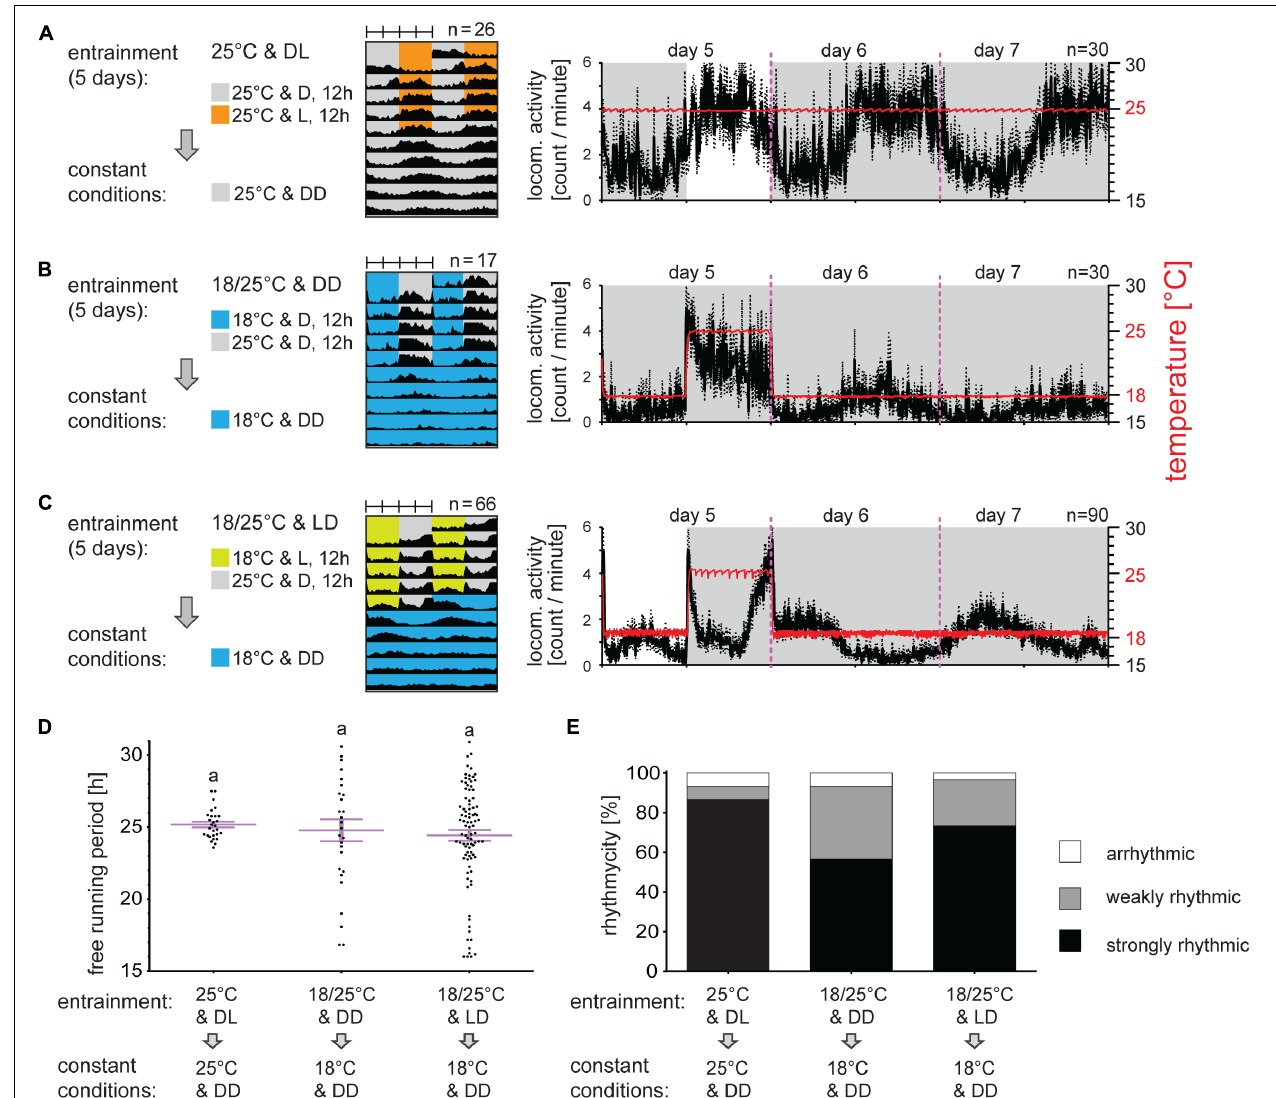
FIGURE 2 | Light is a stronger signal than the temperature for locomotor activity synchronization in P. apterus . Adult males developing under long photoperiod (D6:L18) were entrained by 5 days of short photoperiod D12:L12 (A) , short thermoperiod (B) or conflicting cycles of short photoperiod and thermoperiod where the photophase was combined with the cryophase and the thermophase was combined with the scotophase. After 5 day synchronization, males were released to DD at either 25 ◦ C (A) or 18 ◦ C (B,C) . Double-plotted actograms represent the average activity of all males rhythmic under DD conditions [see panel (E) for the rhythmicity]. Detailed activity profile is plotted from all males for day 5–7 (right panels in (A–C) ). The actual temperature recorded during the experiment is shown in red (right y -axis). The rhythmicity under constant conditions was determined from 10 days and is presented as the free-running period of each individual male (dots) and mean ± SEM shown in magenta (D) , there is no difference in the free-running period between groups ( p > 0.05, Kruskal–Wallis test). The same small letters above categories indicate no statistical difference. The percent of arrhythmic, weakly rhythmic and strongly rhythmic males is shown in panel (E) .